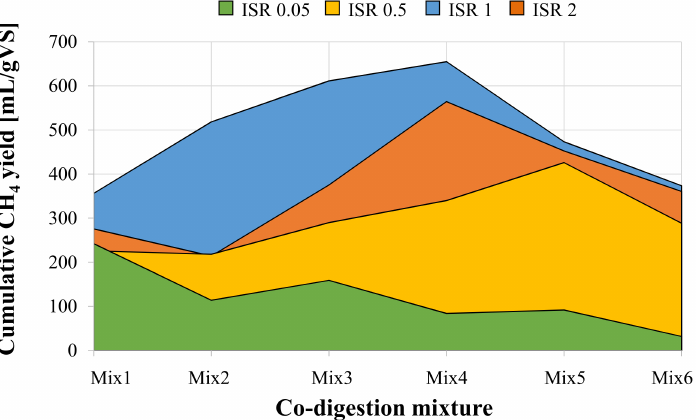
Figure 3. Cumulative methane production obtained in BMP assays at different ISR and mixture